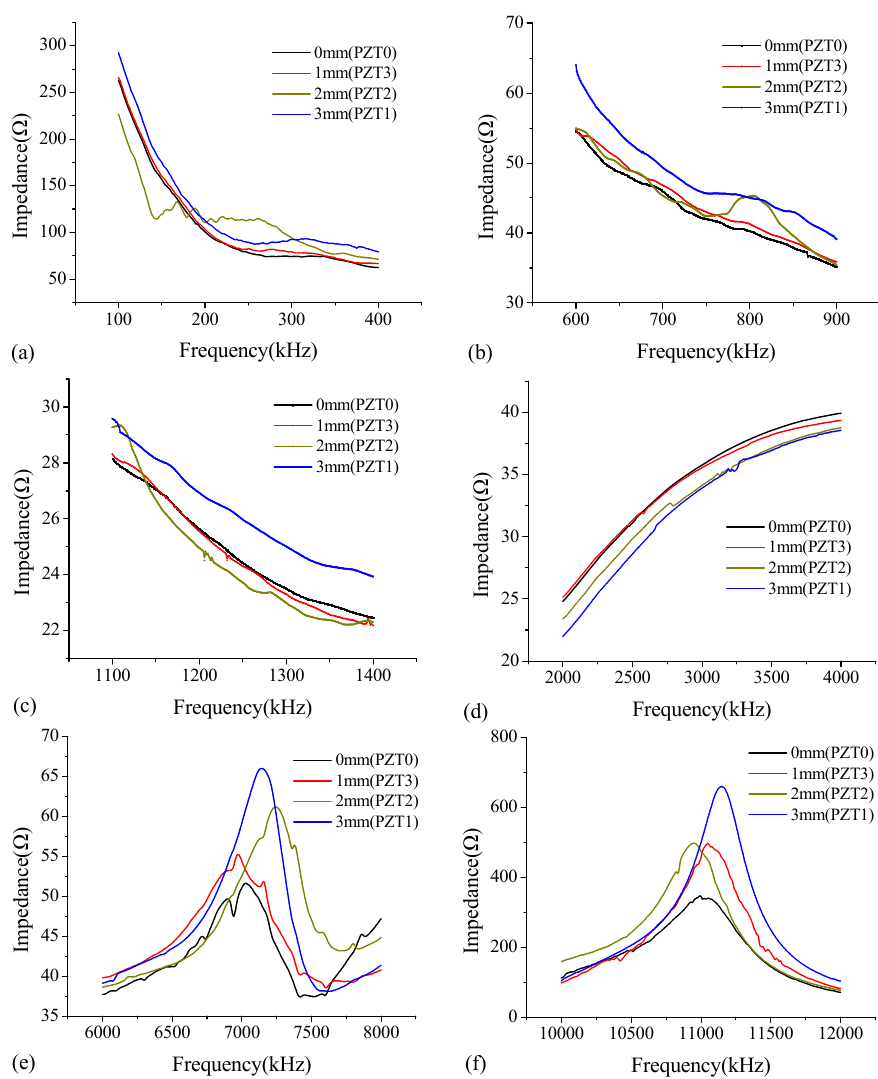
Figure 4. Impedance curve of PZT sensors bonded on the steel plate surface of the B-type specimen under excitation frequency bands of ( a ) 100–400 kHz; ( b ) 600–900 kHz; ( c ) 1100–1400 kHz; ( d ) 2000–4000 kHz; ( e ) 6000–8000 kHz; and ( f ) 10,000–12,000 kHz.